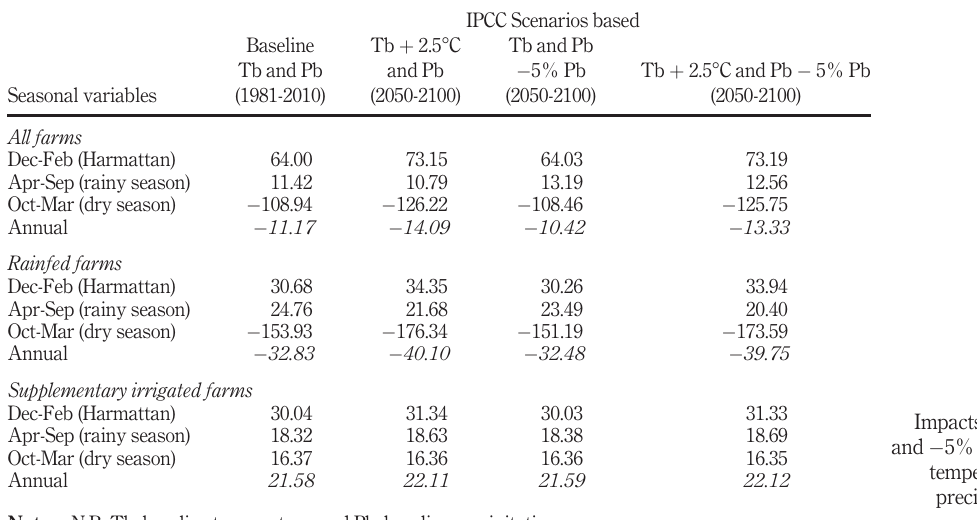
Table V. Impacts of CORDEX